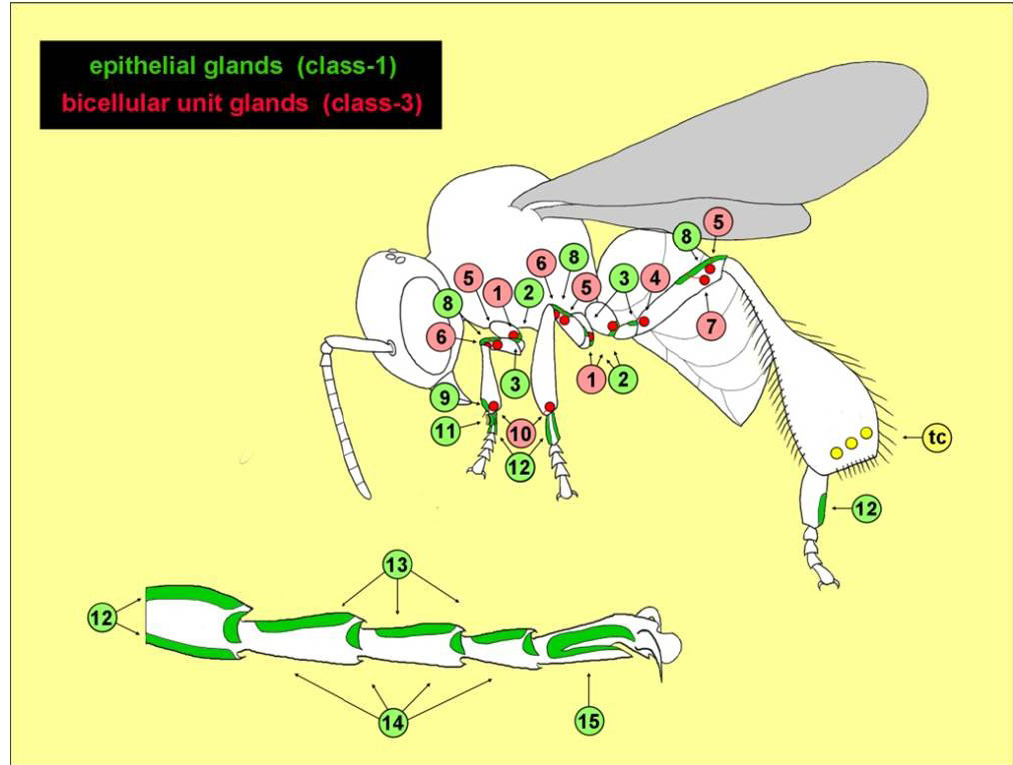
Fig 2 . Schematical survey of the various exocrine glands in the legs of Frieseomelitta varia workers. Gland num- bers correspond with Table 1 and the main text. The anatomical organization in the distal tarsomeres is shown in the detail drawing. tc = undefined tibial cells in the